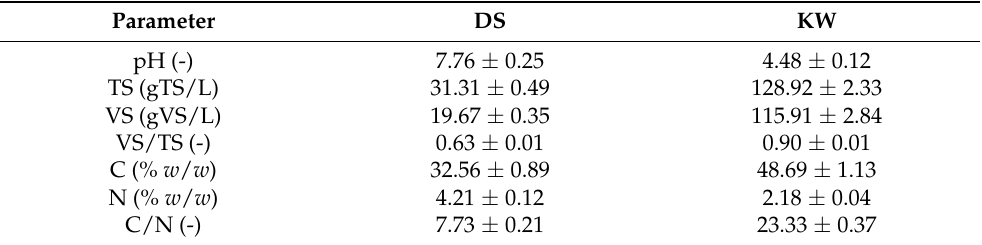
Table 2. Physicochemical parameters of DS (inoculum) and KW (substrate) used in the experiments.